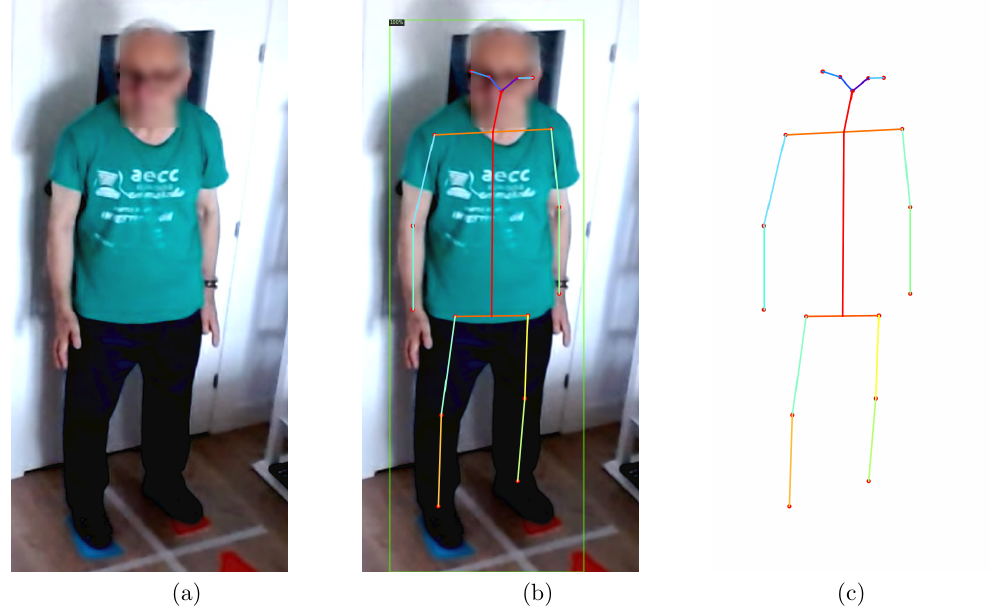
Figure 6. An example frame of a standing-up patient starting the exercises and the output of Detectron2 : anonymized ( a ), anonymized with the skeleton overlapped ( b ), and the points that represent the skeleton on a white background ( c